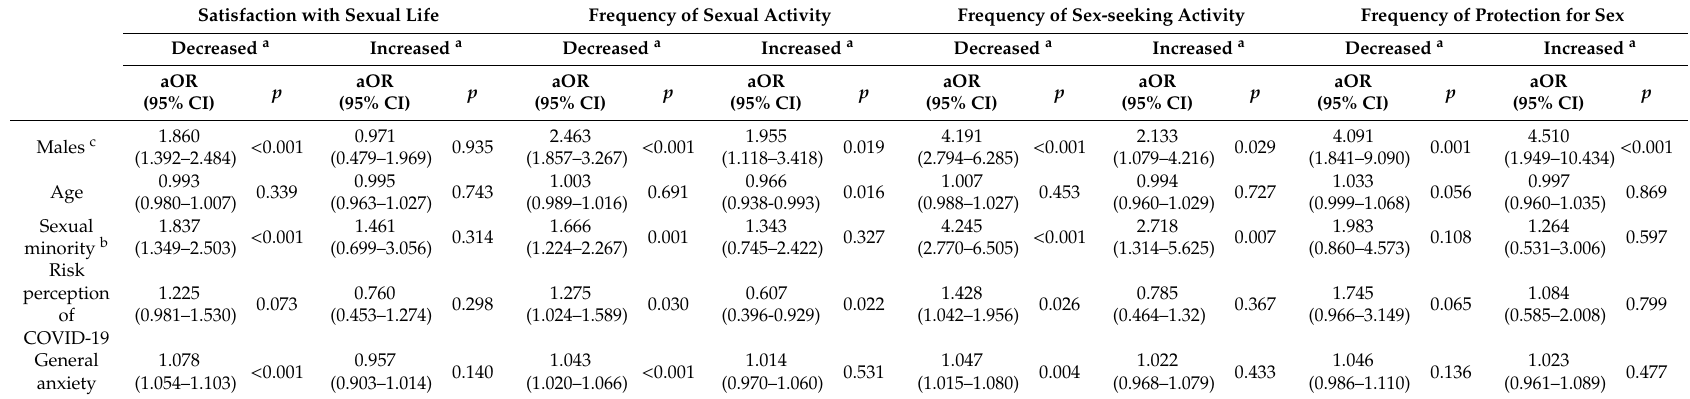
Table 3. Moderators of Associations Between Gender, Age, Sexual Orientation, Risk Perception, and General Anxiety with Changes in Sex Life a. Satisfaction with Sexual Life Frequency of Sexual Activity Frequency of Sex-seeking Activity Decreased b Decreased b Increased b Decreased